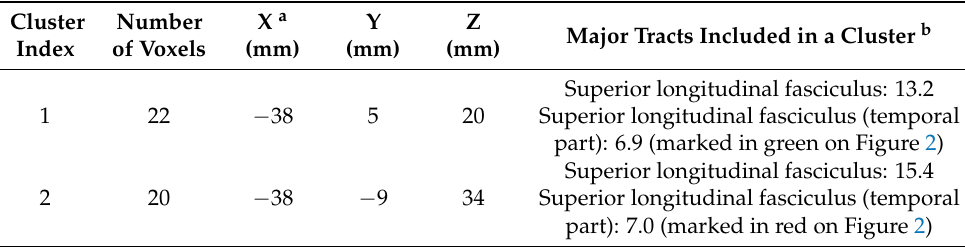
Table 3. Montreal Neurological Institute (MNI) space co-ordinates, number of voxels, and major white matter tracts included in the two significant clusters, labeled Cluster 1 and Cluster 2, respectively. The numbers after each tract label indicates the percentage probability of the cluster to belong to the given JHU white matter tractography atlas